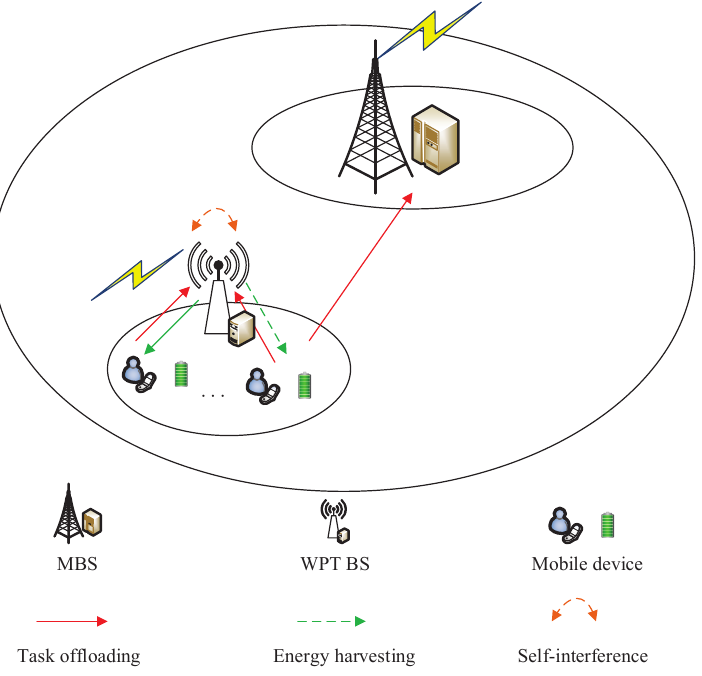
Figure 1. MEC offloading system model for wireless energy